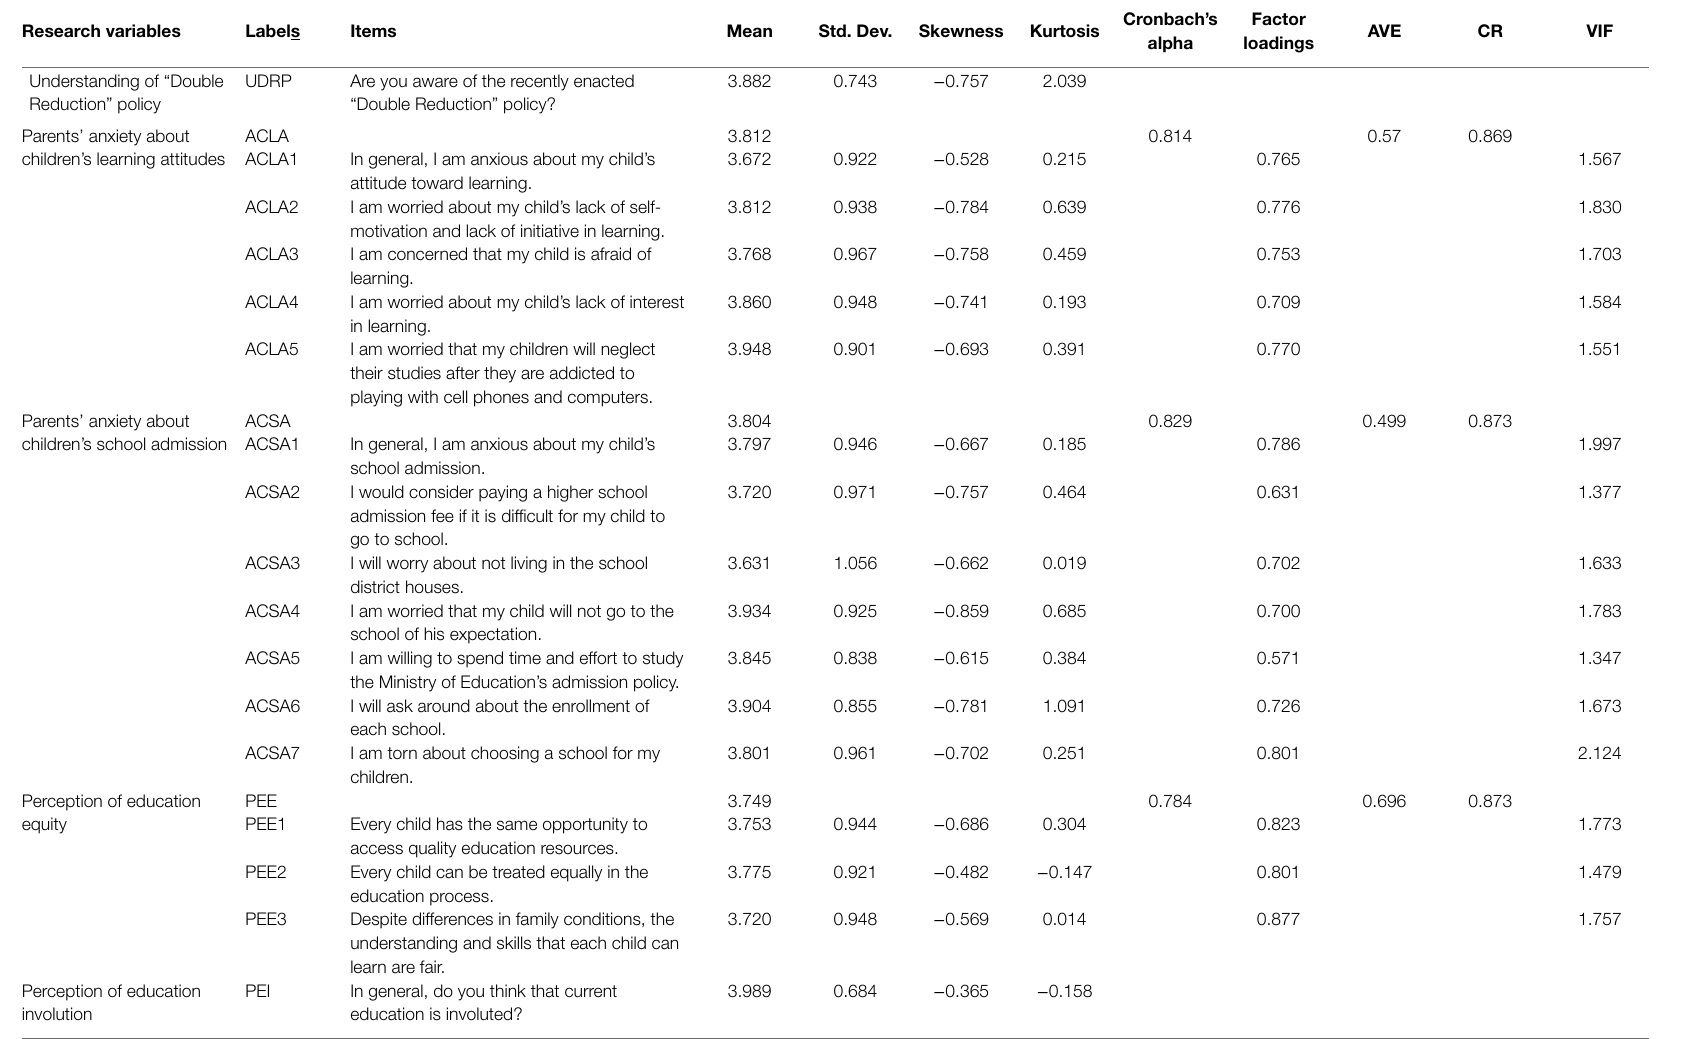
TABLE 2 | Reliability and validity of the constructs. Research